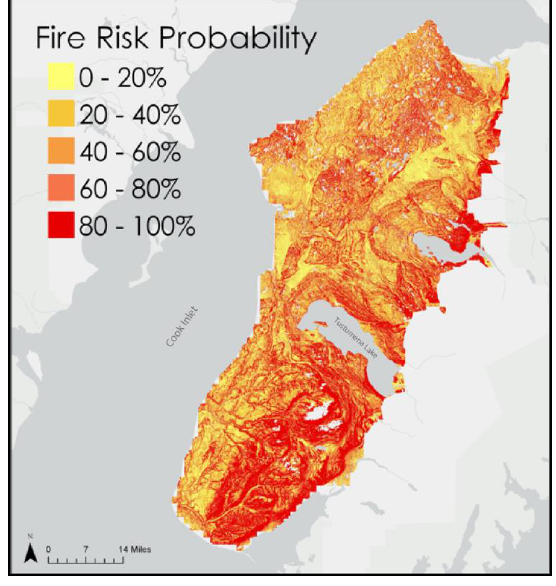
Figure 6. Fire Danger Map. Table 3. Model Confusion Matrix Probability of Detection (POD) and False Alarm Ratio (FAR) 1.